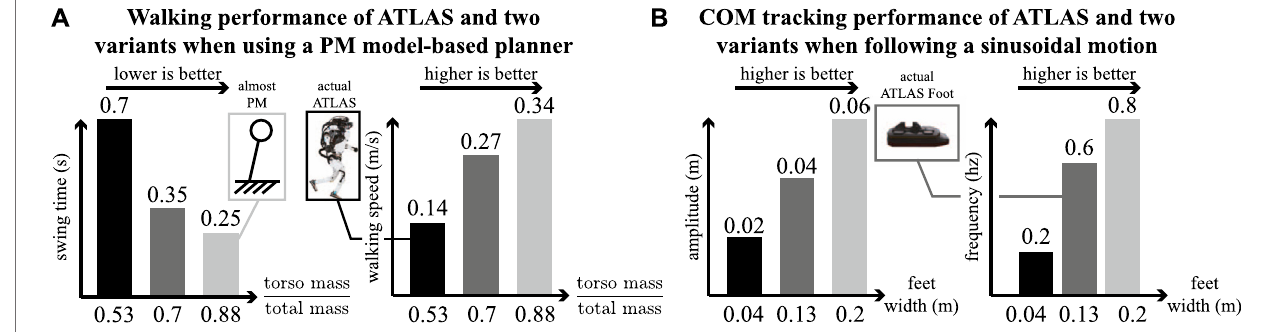
FIGURE 1 | Sensitivity analysis on walking and COM tracking performance based on the robot ’ s mass distribution and feet size. (A) We created two variations of ATLAS by reducing its extremities masses and evaluated the resulting walking performance using a PM model-based planner (Englsberger et al. (2015)). As the robot ’ s mass distribution resembles a PM model (i.e., its distal mass becomes negligible), the robot is able to achieve faster walking speeds. (B) Similarly, we created two variationsofATLASbychangingitsfeetwidthandevaluateditsCOMtrackingperformanceduringmovementsinthedoublesupportstance.Astherobot ’ sfeetget wider, it ’ s able to track more aggressive sinusoidal